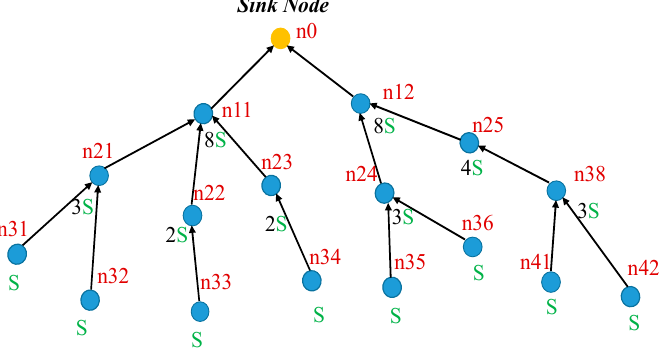
Figure 8. Data aggregation in tree-structured WSN.